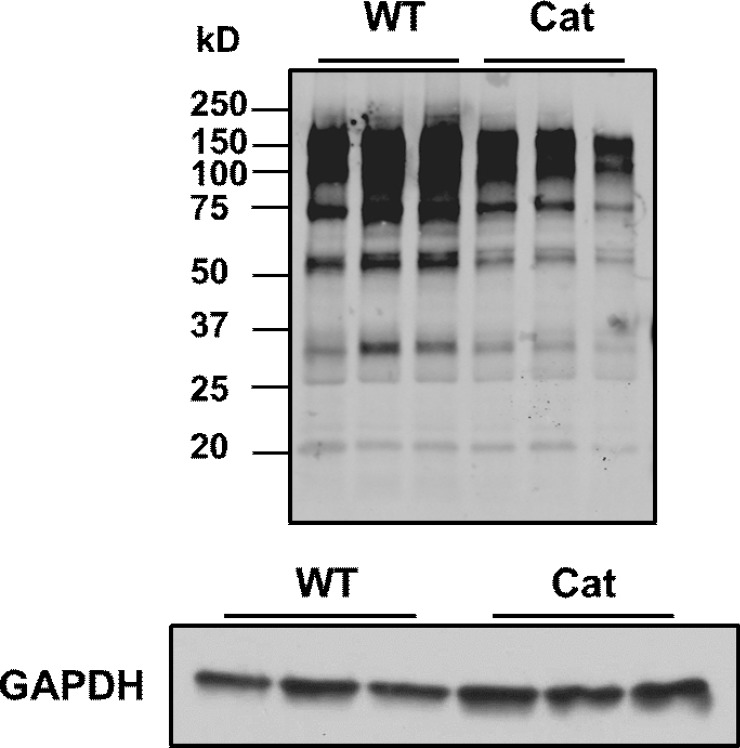
Protein-GSH adduct levels are decreased in catalase transgenic mice.Consistent with the decrease in H2O2 formation, protein GSH adducts were decreased in catalase transgenic mouse hearts, as measured by Western blotting analysis using an anti-GSH adduct antibody. GAPDH protein levels in hearts were analyzed by Western blot to ensure equal protein loading.